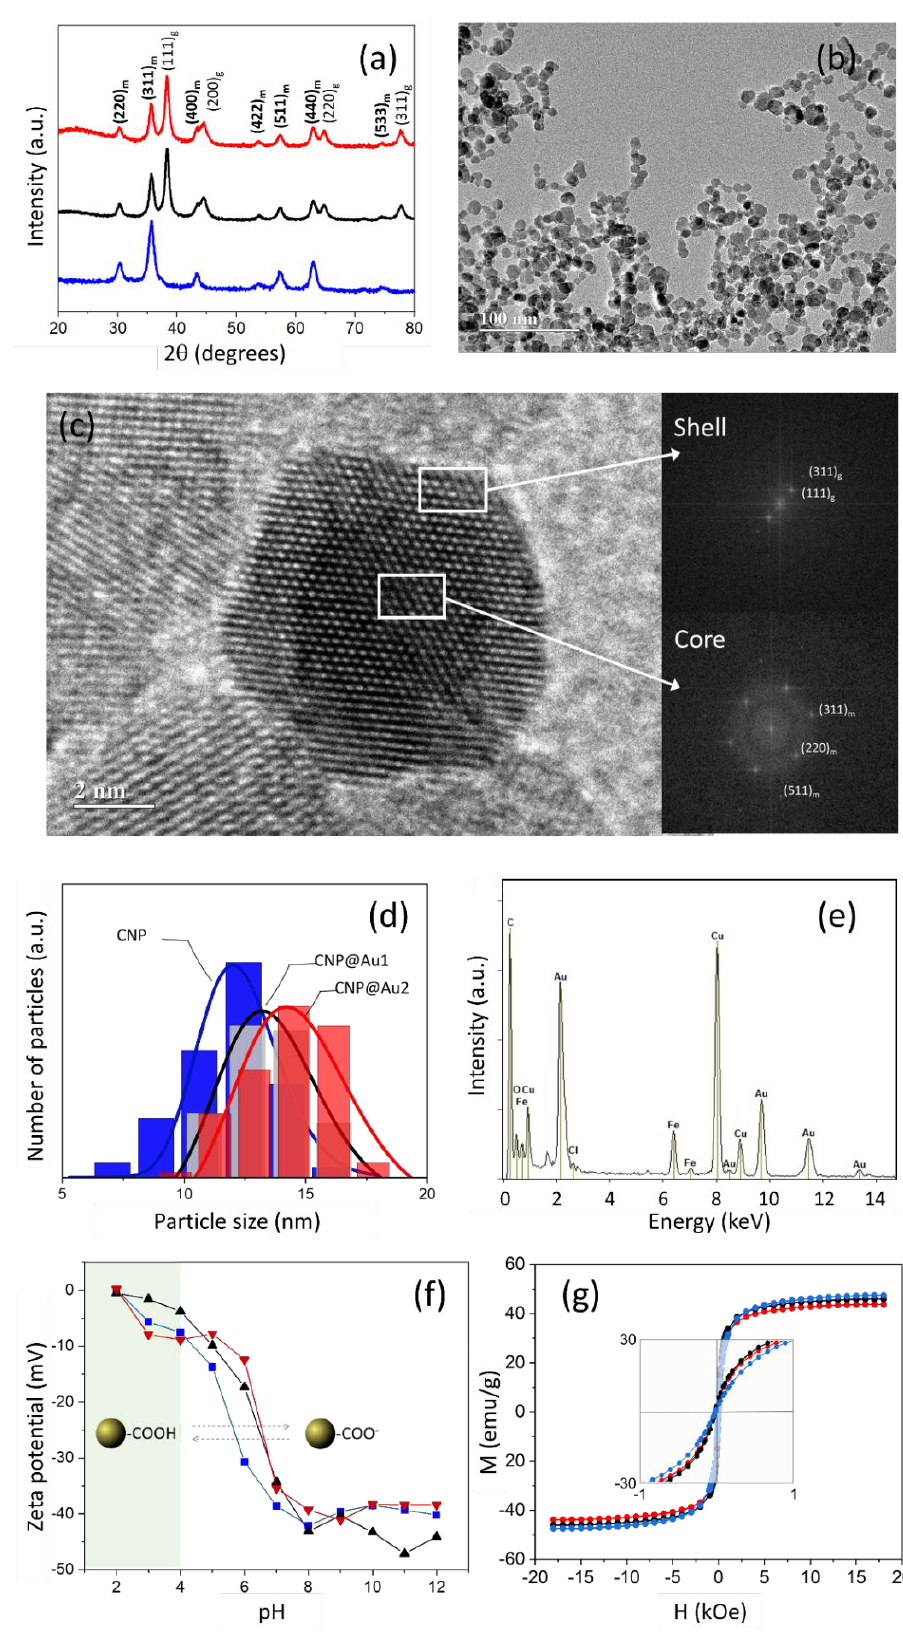
Figure 2. ( a ) The X-ray diffraction patterns of CNP (blue), CNP@Au1 (black) and CNP@Au2 (red), in which the main diffraction peaks of the maghemite (m) phase are indicated by the red pattern (30.3° (220), 35.6° (311), 43.3° (400), 53.7° (422), 57.3° (511), 62.9° (440) and 74.5° (533)) and the main